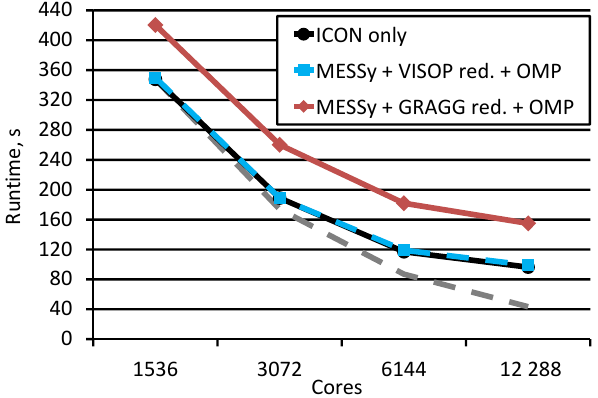
Figure 7. Comparison of the runtime (s) of VISOP and versions of VISOP with reduced call frequency, OpenMP, and a combination of both. Output was activated in all test cases.